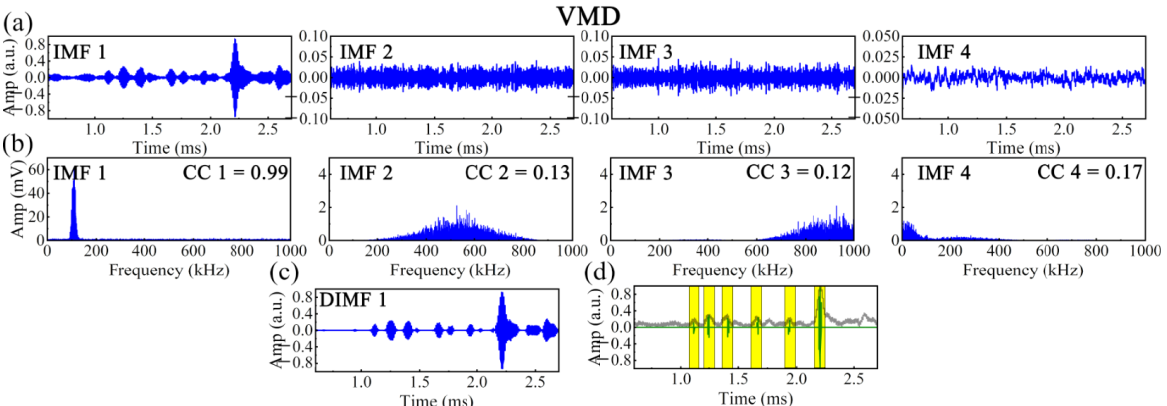
Figure 19. IMFs of VMD in the ( a ) time and ( b ) frequency domains; ( c ) VMD + WT and ( d ) VMD + WT + ISSP processing results of EUS 8.